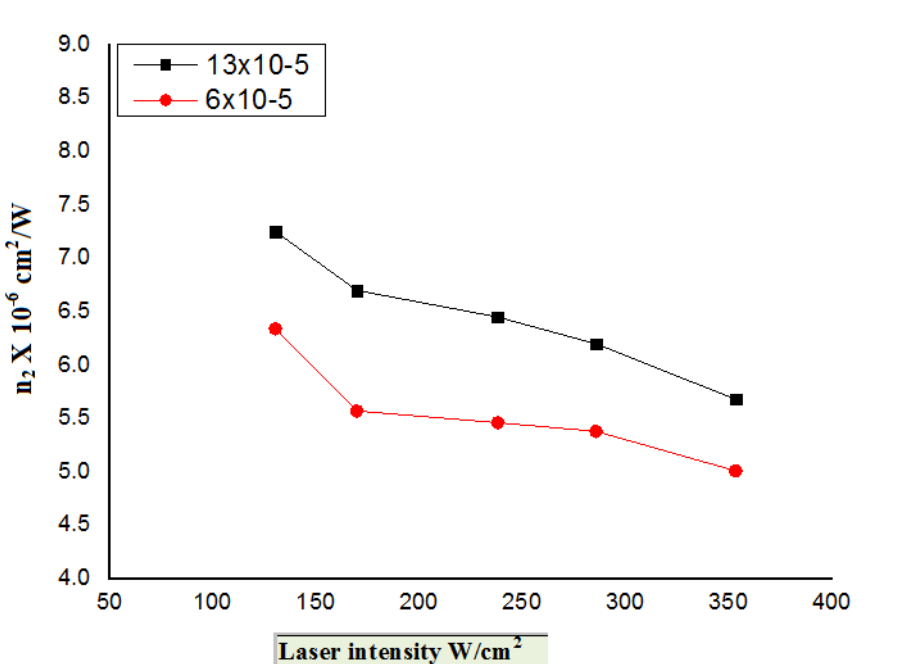
Fig.11: The non-linear refractive index produced at SWCNTs Nanoparticals DI water suspension at volume fractions of 13x10 -5 and, 6x10 -5 in different laser intensities.